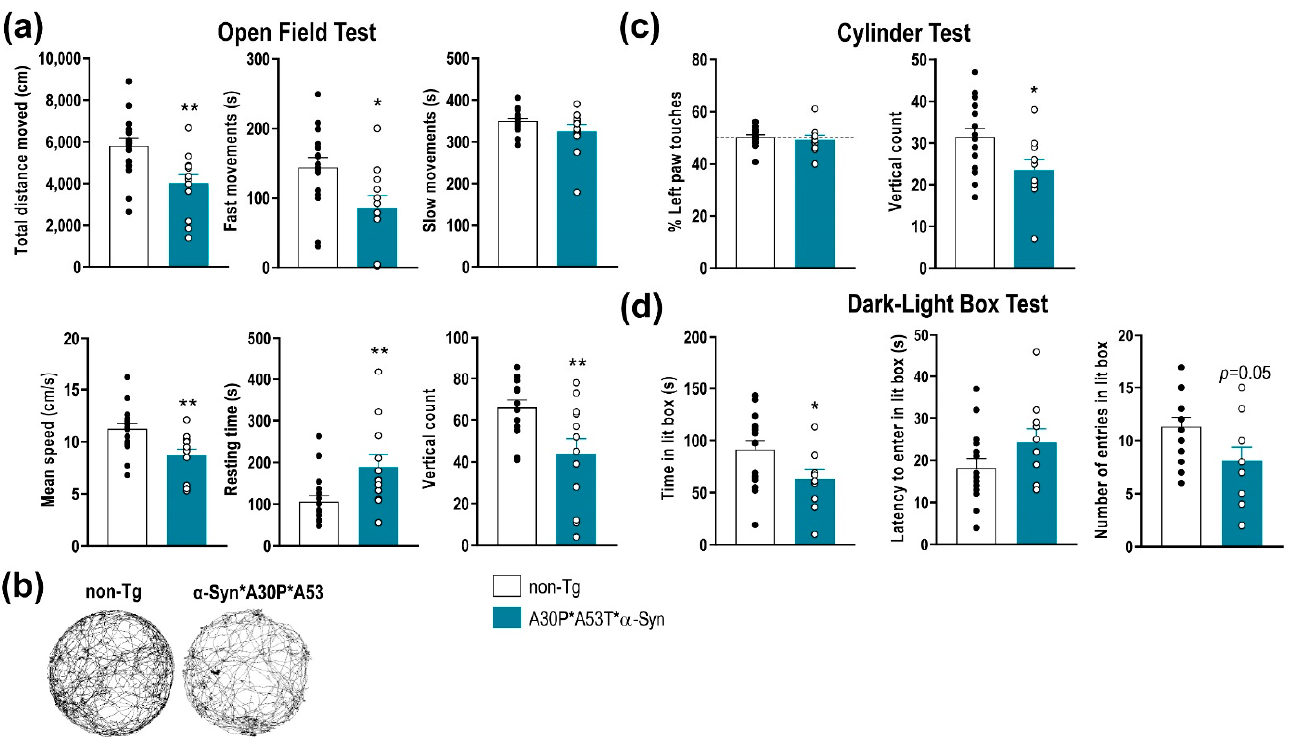
Figure 3. Impairment of motor function and anxiety-like behaviors in A30P*A53T* α -Syn transgenic mice. ( a ) Comparison of spontaneous locomotor activity between 5-month-old A30P*A53T* α -Syn and non-Tg mice in the open field test. Total distance traveled, fast movements, average speed and vertical count were significantly decreased in A30P*A53T* α -Syn mice compared with non-Tg mice. In parallel, transgenic mice showed an increased resting time compared with non-Tg mice. ( b ) Representative locomotor activity tracking was obtained from both phenotypes. ( c ) No difference in motor asymmetry examined by the use of the left paw was detected. However, A30P*A53T* α -Syn mice showed a reduced vertical count in the cylinder test compared with non-Tg mice. ( d ) In the dark-light box test, A30P*A53T* α -Syn transgenic mice evoked an anxiety-like response compared with non-Tg mice, as shown by the shorter spent time in the lit box but the marginal effects in the latency period to entering in the light box or the number of entries. Data are the mean ± SEM, n = 10–15 mice/group. Student’s t- test, * p < 0.05, ** p < 0.01 compared with non-Tg mice. See also Supplemental Figure S2.